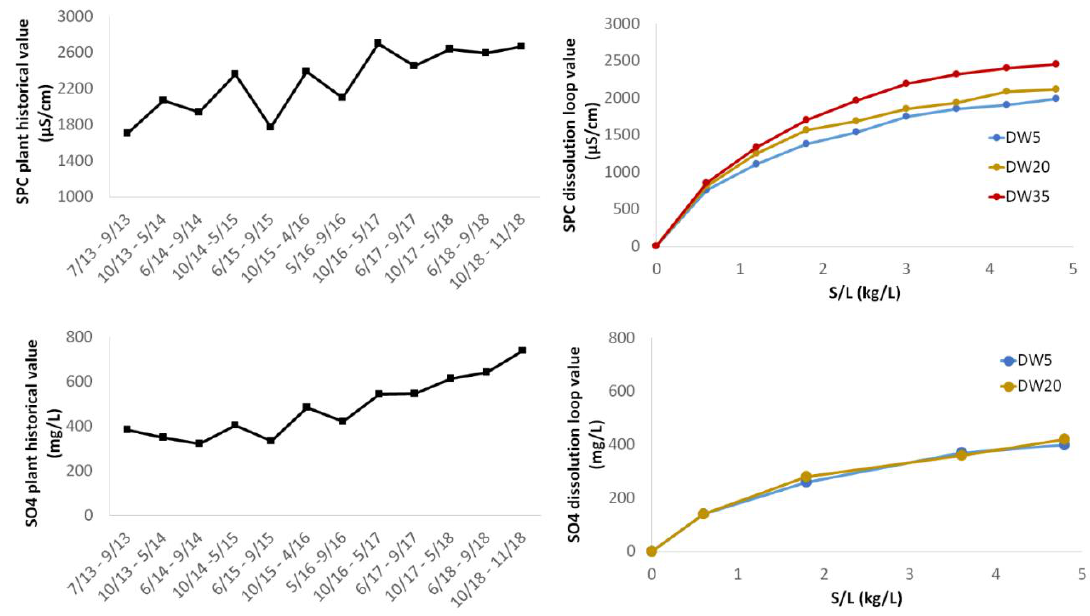
Figure 6. Process water SPC as a function of operational time at Kevitsa mine (left) and the change in SPC in the recycled water as a function of the S/L ratio (right).